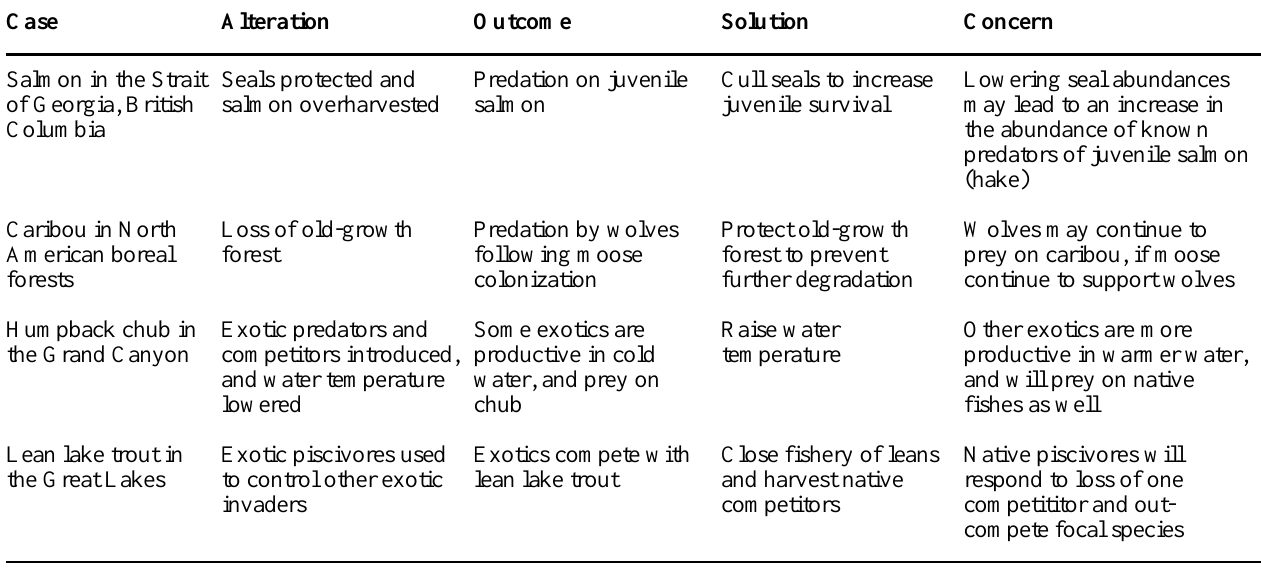
Table 1 . Summary of case studies.